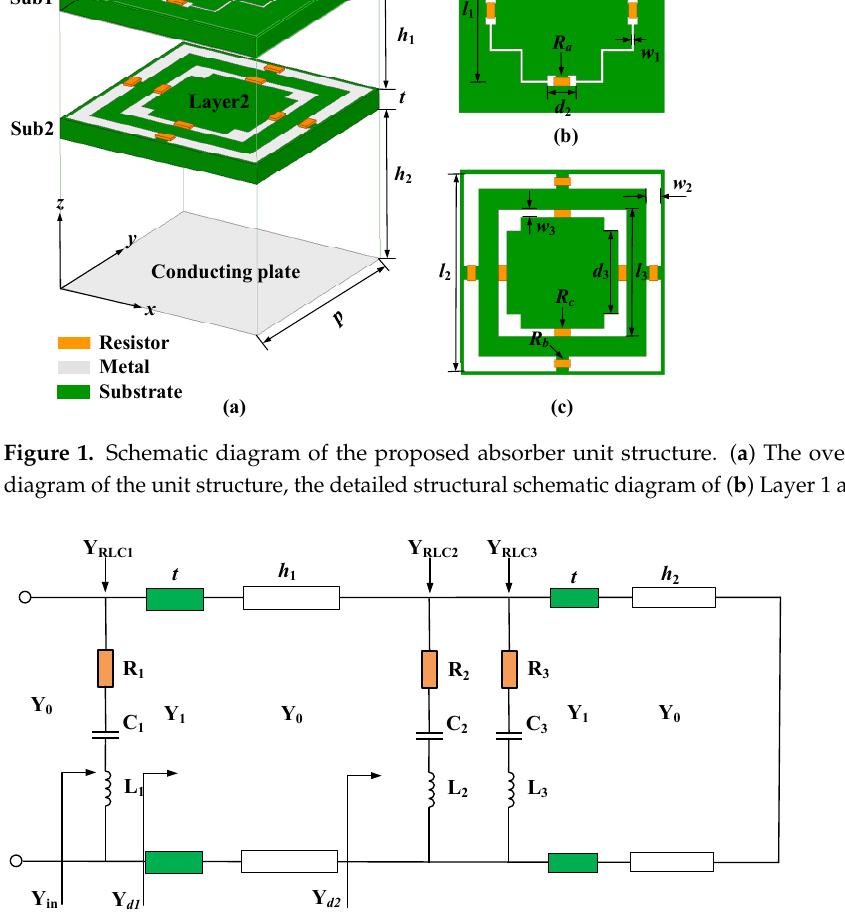
Figure 1. Schematic diagram of the proposed absorber unit structure. ( a ) The overall schematic dia- gram of the unit structure, the detailed structural schematic diagram of ( b ) Layer 1 and ( c ) Layer 2.